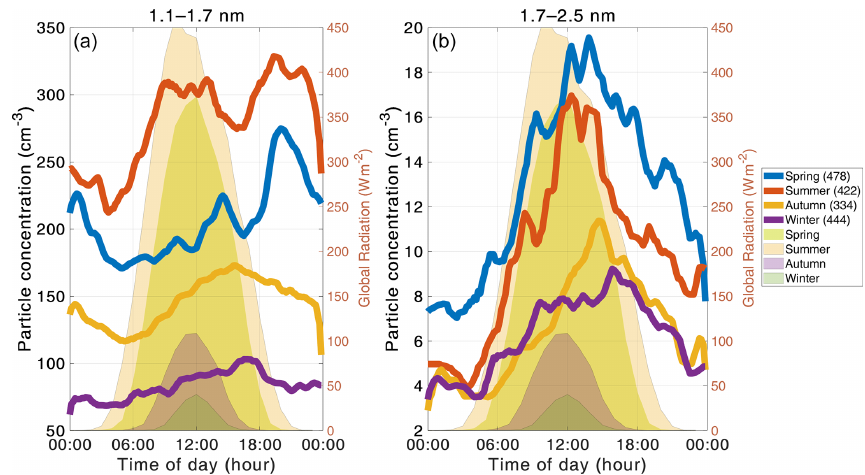
Figure 7. The median diurnal cycles of the particle concentrations in different seasons. Panel (a) shows the 1.1–1.7nm particle concentration seasonal diurnal cycles and (b) shows the 1.7–2.5nm particle concentration seasonal cycles. The blue, red, yellow, and purple lines show the seasonal diurnal cycles spring, summer, autumn, and winter, respectively. The area plots in the background present the seasonal diurnal cycle for each season. The light green, light yellow, lilac, and dark green shading represent spring, summer, autumn, and winter, respectively. The number of days included in the median day is presented by the number in parentheses in the